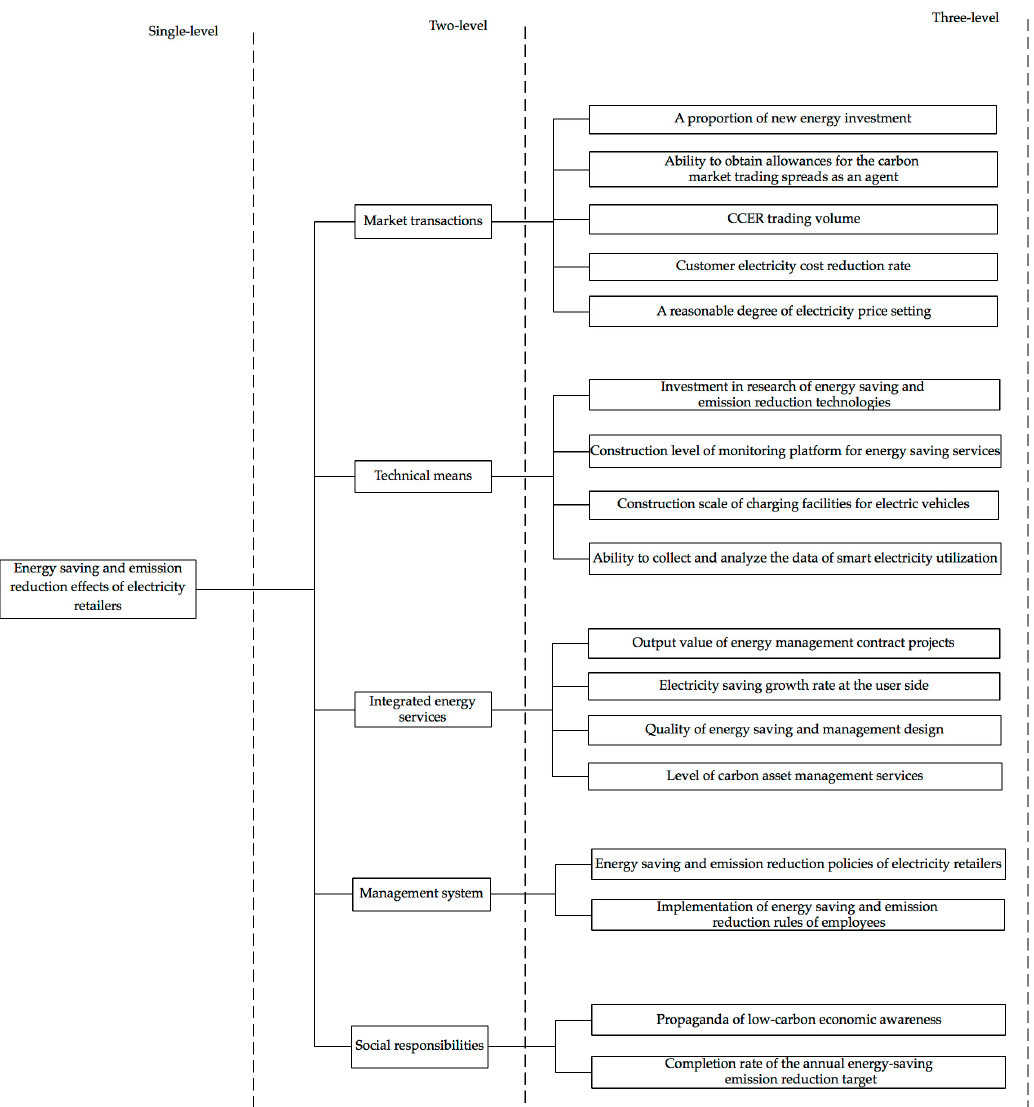
Figure 2. The three-level evaluation indicator system of the energy saving and emission reduction effects for electricity retailers in China.